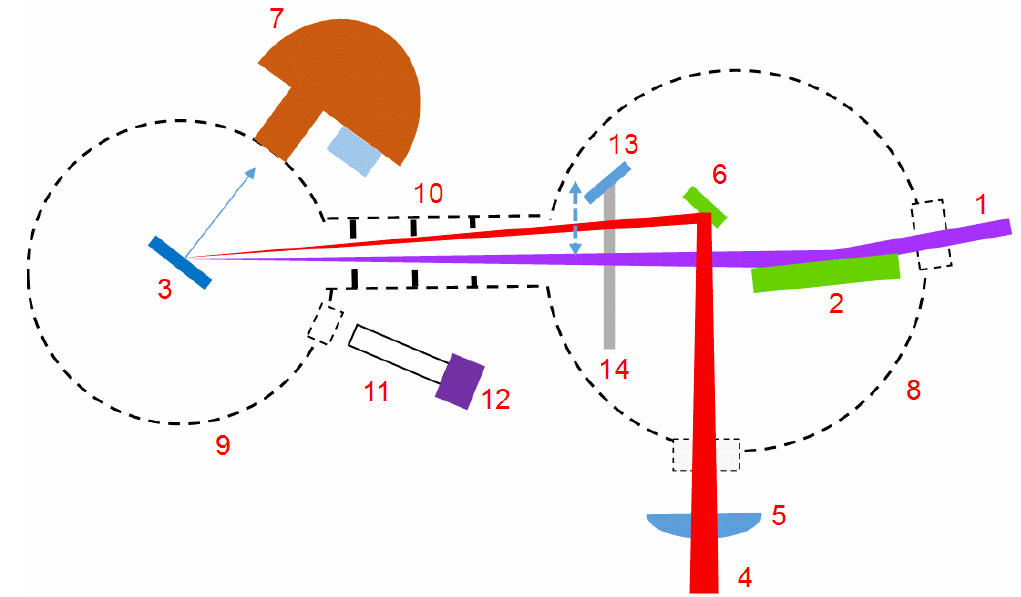
Figure 5. The optical diagram of focusing and recombination chamber: (1) EUV pulse from the monochromator; (2) EUV focusing toroidal mirror on a 5-axis stage; (3) sample materials or CE:YAG crystal; (4) Excitation laser pulse (ELP) from the variable delay line (VDL); (5) AR-coated plano convex lens with a focal length of f = 1.3 m. (6) The D-shaped re-combination mirror, reflecting ELP; (7) Spin-ARPES detector; (8) Focusing and recombination chamber; (9) Spin-ARPES vacuum chamber; (10) Differential pumping system with three pinholes; (11) Telescope; (12) CCD camera; (13) Plane golden mirror for observing the overlapping of two beams; (14) Linear